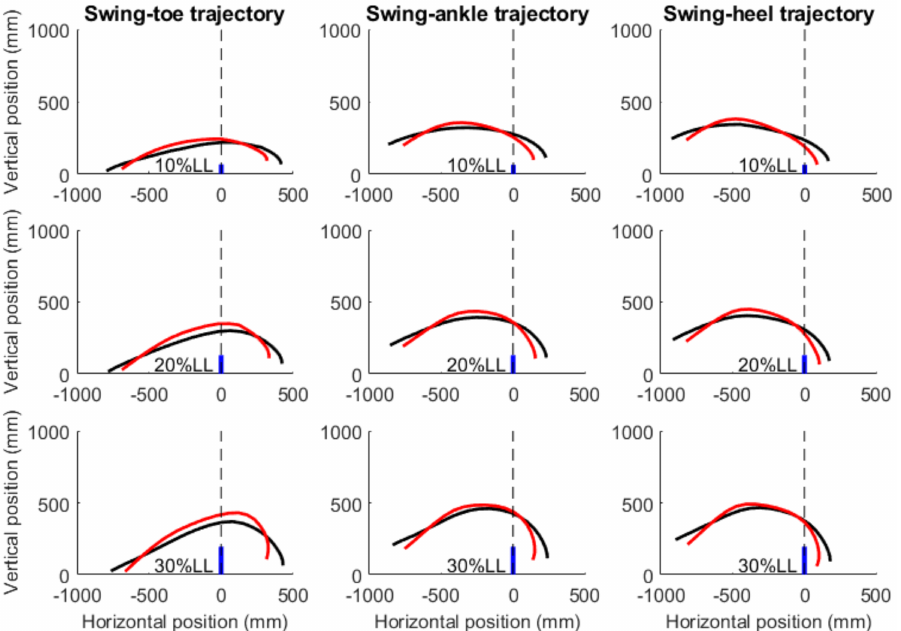
Figure 2. Sagittal trajectories of the ankle, toe, and heel of the leading swing limb of typical subjects of the older ( red curves ) and young ( black curves ) groups when crossing obstacles ( solid blue lines ) of 10%, 20%, and 30% of leg length (LL).